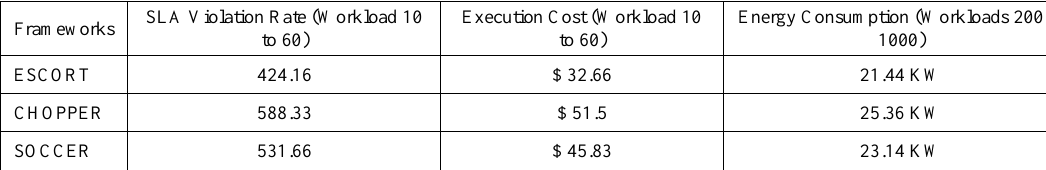
Table 6. Analysis of performance metrics